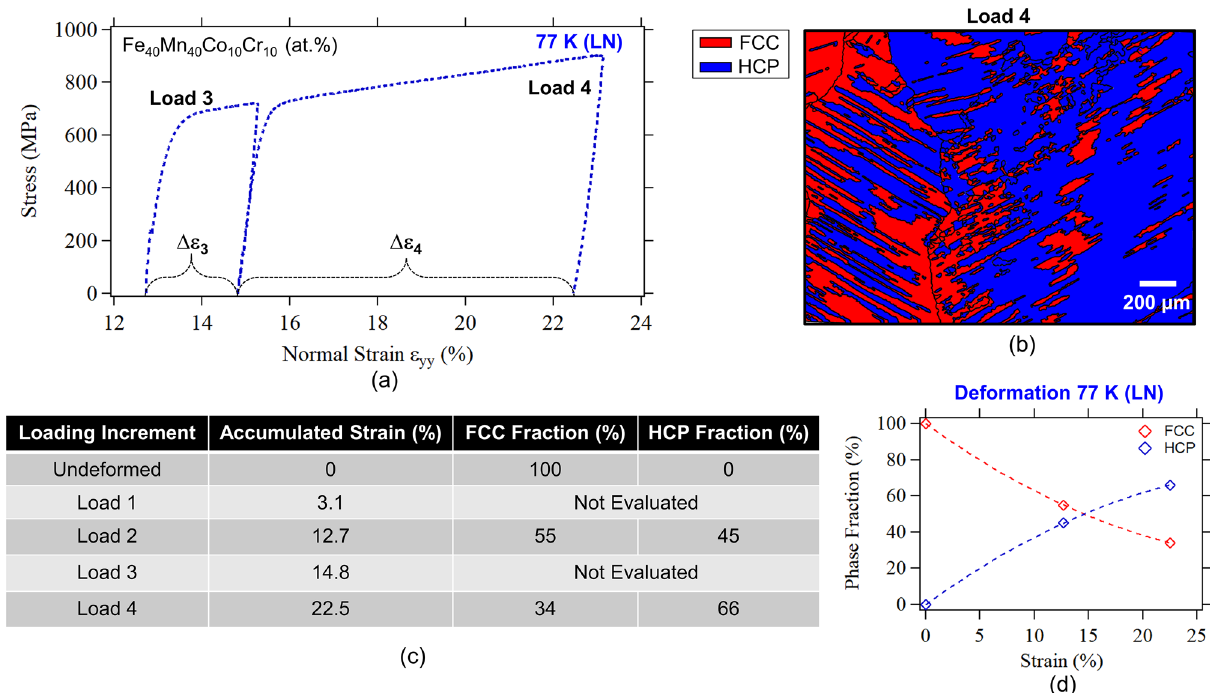
Figure 4. ( a ) Stress–strain curves following incremental loading at 77 K. Deformation increments Load 3 (13– 15% strain) and Load 4 (15–22.5% strain) are shown. Previous loading cycles are presented in Fig. 3. ( b ) Phase map obtained from the gauge section following Load 4 which corresponds to a total of 22.5% plastic strain. The FCC and HCP phase volume fractions as a function of loading are summarized in Table ( c ) and plot ( d ).